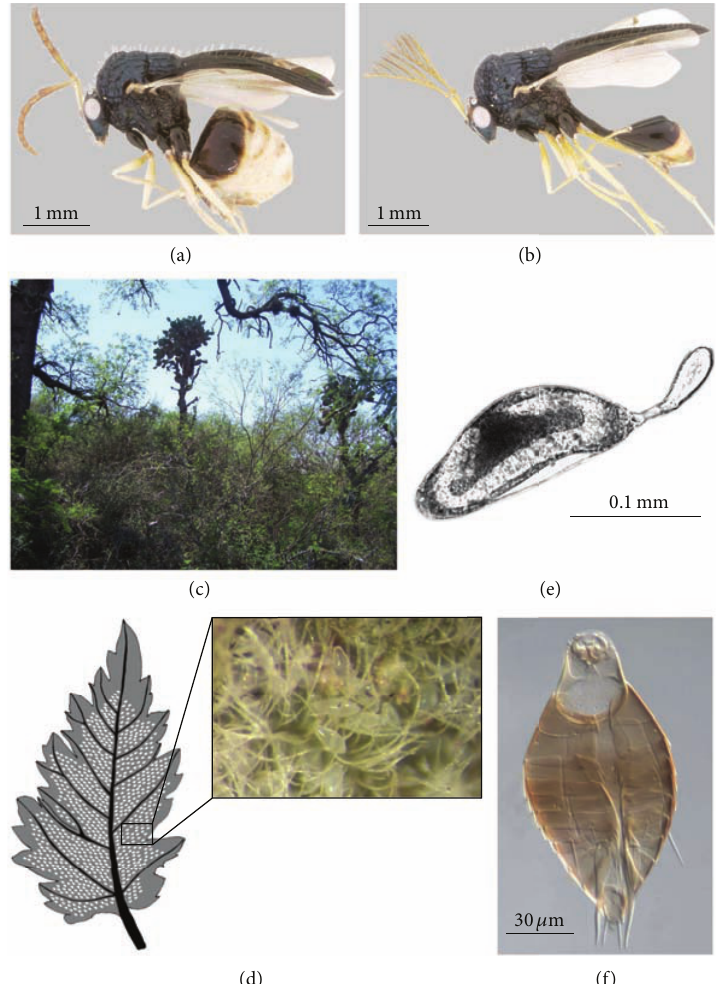
Figure 7: Neolirata daguerrei : (a) habitus (female); (b) habitus (male). Biology and immature stage of N. daguerrei : (c) habitat; (d) underside of leaf of Urvillea chacoensis with eggs (eggs represented in white area and magnified); (e) egg; (f) planidia. Figures extracted from [15].